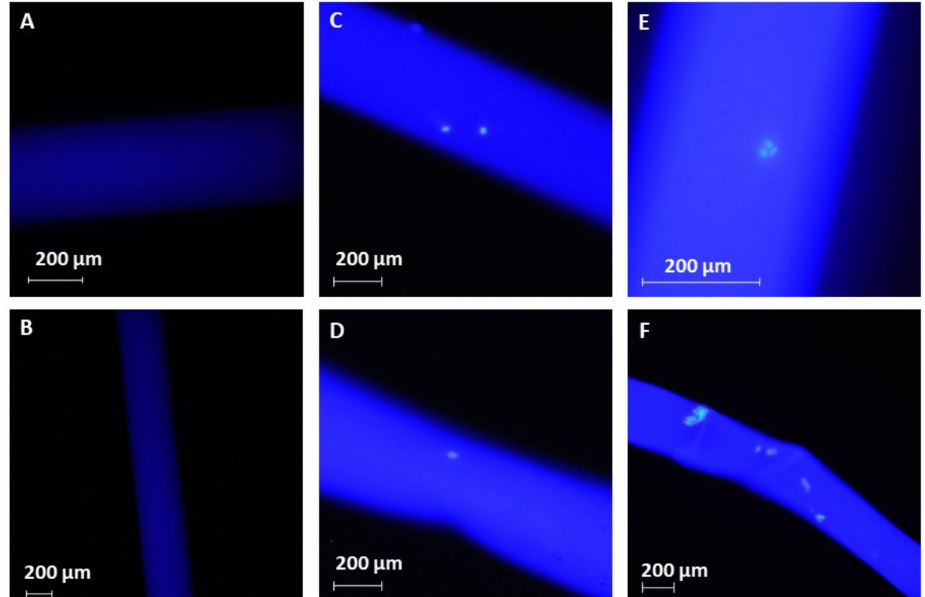
Figure 2. Fluorescence images of the treated fibers. Panels ( A , B ): background illumination of the untreated fibers. Panels ( C – F ): efficient HCT116 cell capture (green signal) from spiked PBS buffer. The intensive blue illumination in panels ( C – F ) demonstrates the efficient anti-EpCAM immobilization. Images were taken using a Nikon Eclipse Ni fluorescence microscope equipped with a DAPI (ex.: 375 nm/em.: 460) bandpass filter